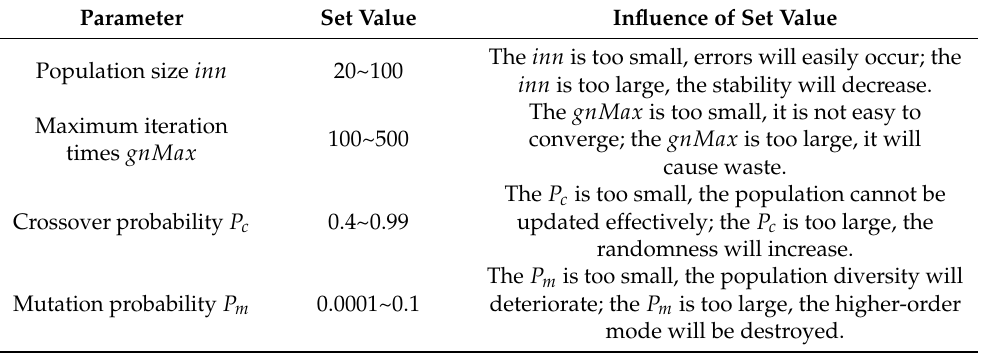
Table 6. Range of genetic algorithm parameters.